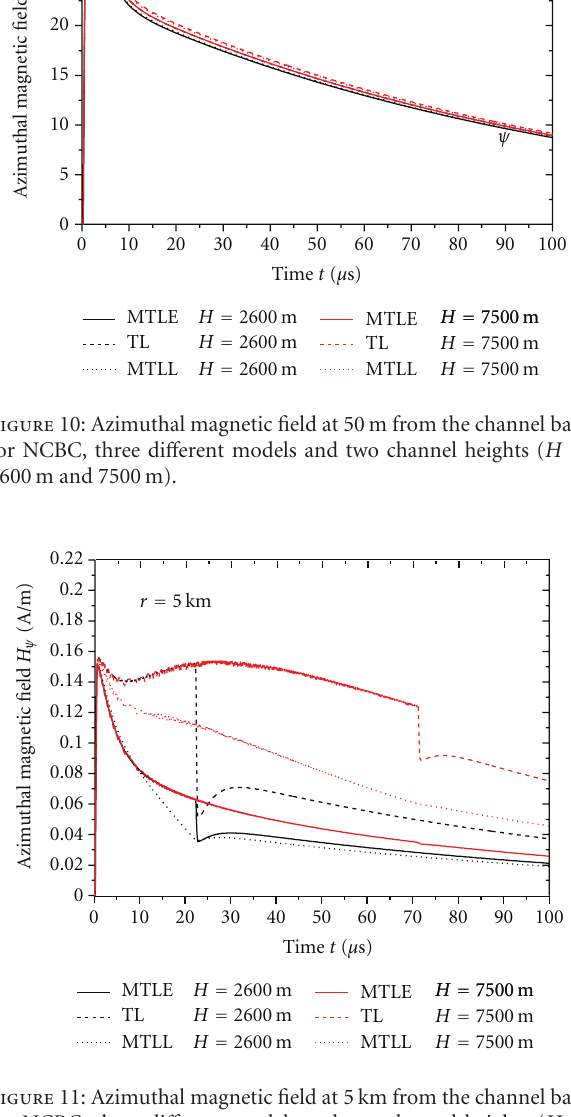
100 km from the channel